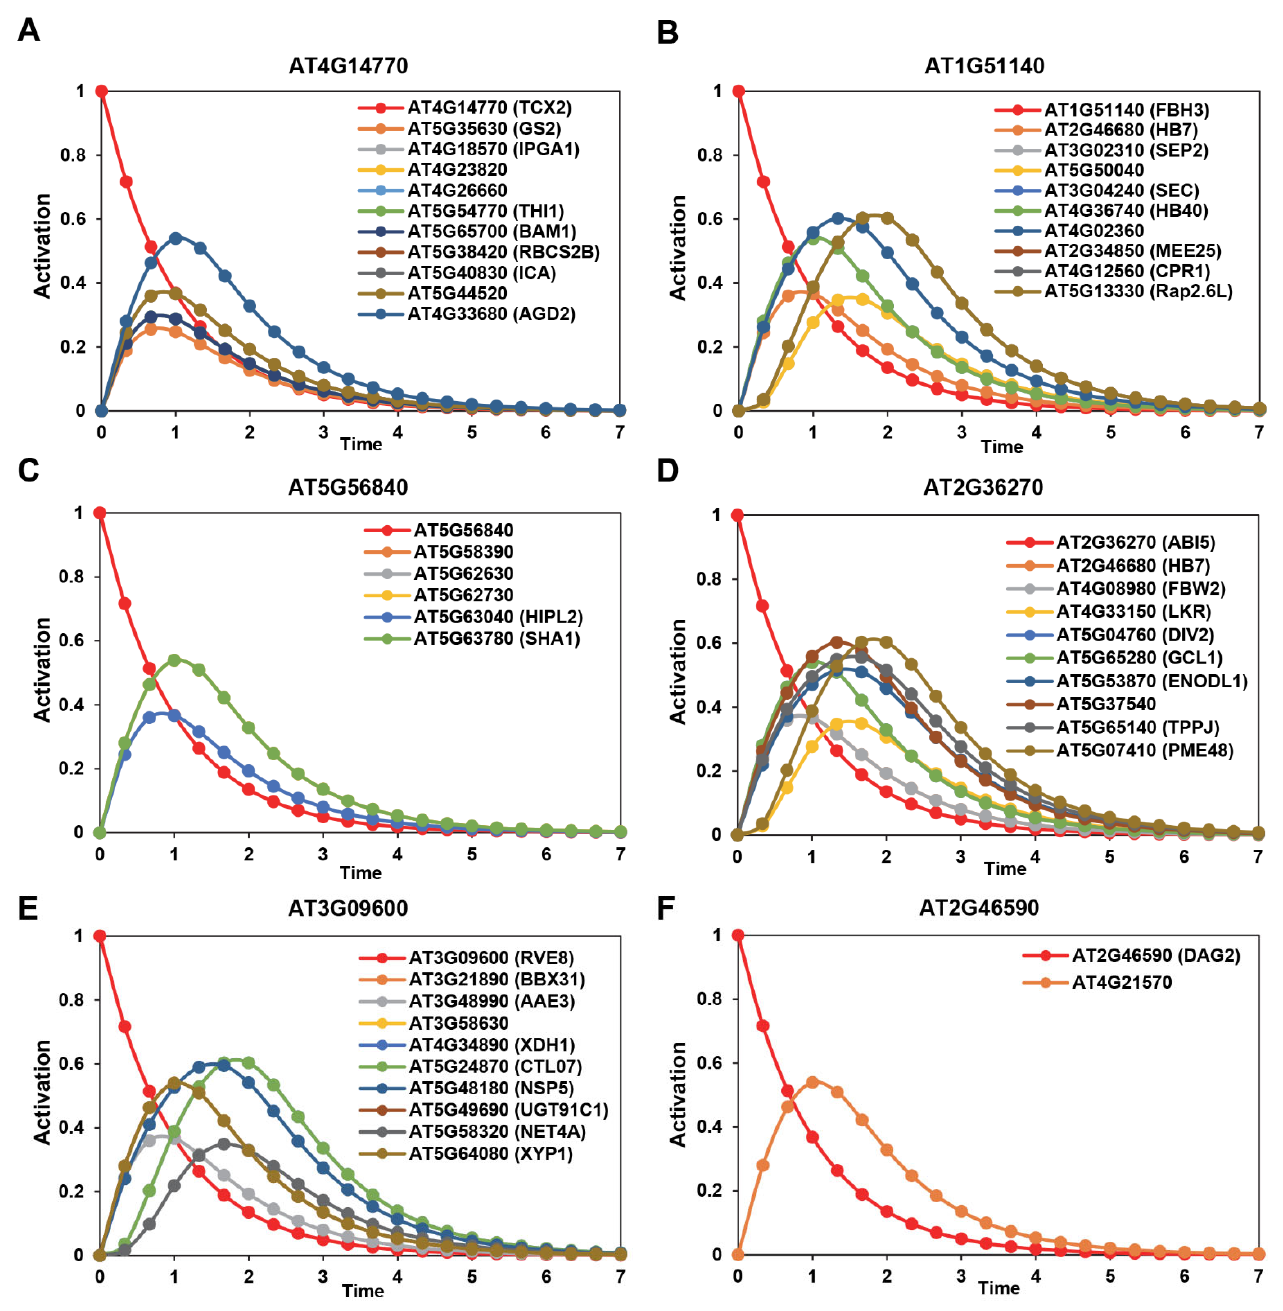
Figure 4. ( A – F ) The dynamic modeling and simulation of transcription factor regulatory network’s activity upon activation of six transcription factors (AT4G14770, AT1G51140, AT5G56840, AT2G36270, AT3G09600, and AT2G46590) identi fi ed by SQUAD. Activation pa tt erns of the TFs are shown in red lines whereas individual target genes’ activation is illustrated in di ff erent colors.